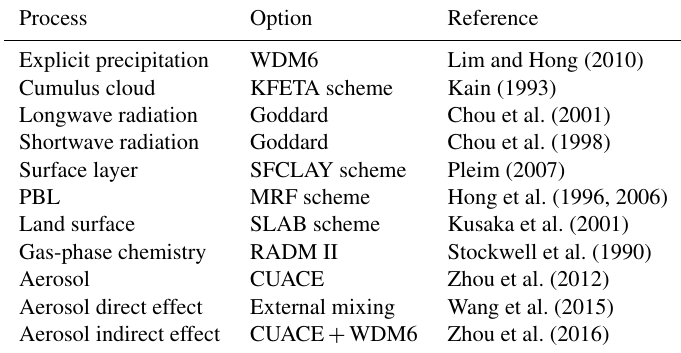
Table 1. Physical and chemical processes in GRAPES_CUACE. Process Option Reference Explicit precipitation WDM6 Lim and Hong (2010) Cumulus cloud KFETA scheme Kain (1993) Longwave radiation Goddard Chou et al. (2001) Shortwave radiation Goddard Chou et al. (1998) Surface layer SFCLAY scheme Pleim (2007) PBL MRF scheme Hong et al. (1996, 2006) Land surface SLAB scheme Kusaka et al. (2001) Gas-phase chemistry RADM II Stockwell et al. (1990) Aerosol CUACE Zhou et al. (2012) Aerosol direct effect External mixing Wang et al. (2015) Aerosol indirect effect CUACE + WDM6 Zhou et al.